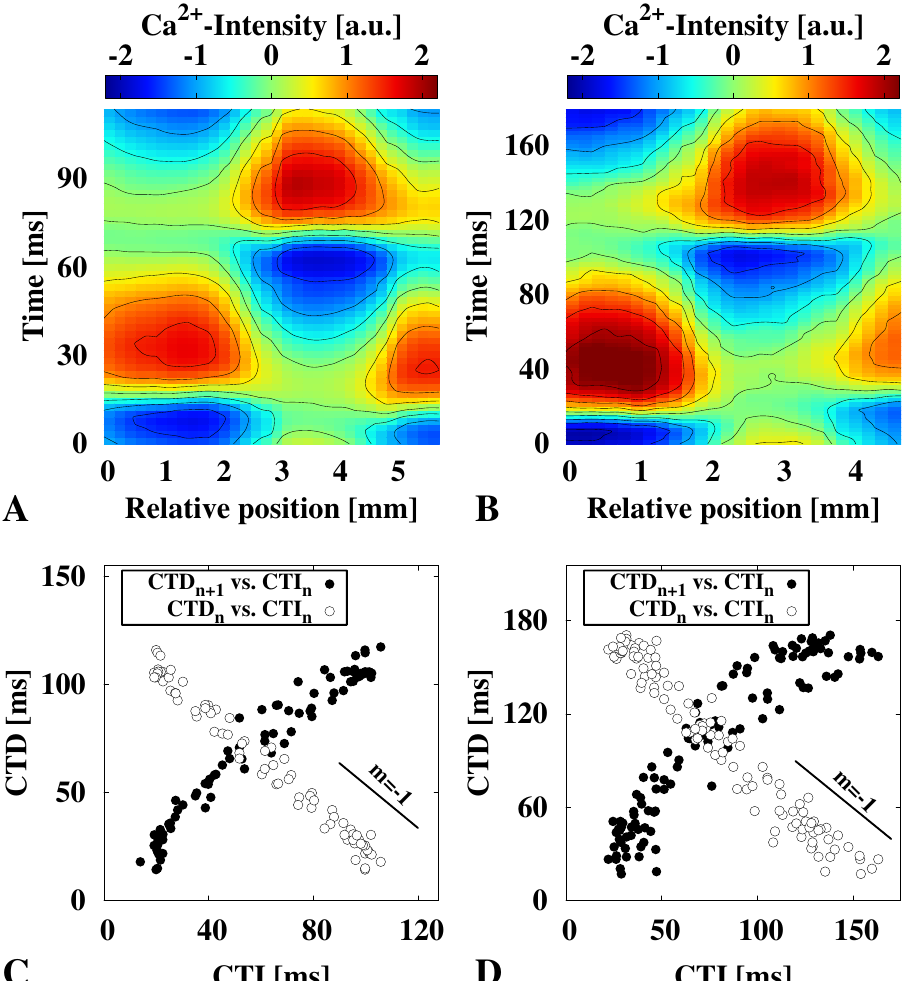
Figure 3. Spatiotemporal cobweb dynamics in concordant alternating spiral waves. ( A and B ) show the double period ( f 1/2 ) of the cytosolic calcium signaling along the line segments shown in Fig. 2A. The corresponding spatial cobweb dynamics are shown below in ( C and D ), respectively. The black circles indicate the restitution curve of the respective wave dynamics. The white circles highlight the slope of the intrinsic frequency f at which the spiral wave rotates around the wave singularity, and the obstacle, respectively, where f can be obtained as the interpolation to f − 1 = CTI(CTD = 0) or f − 1 = CTD(CTI =